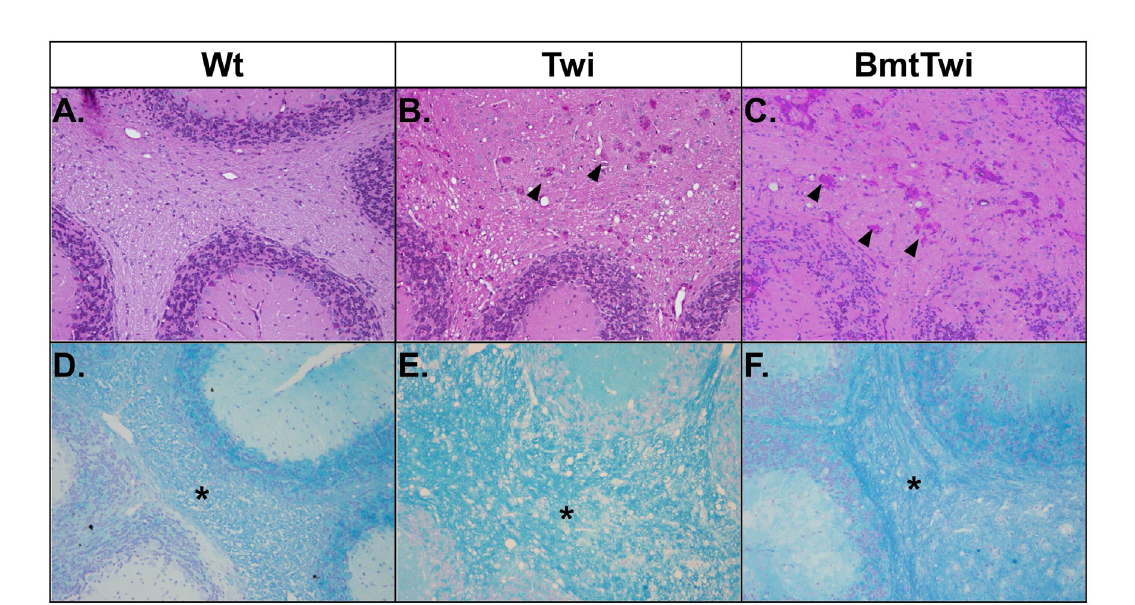
Figure 6. Histology—PAS and LFB staining. There are no identifiable PAS-positive cells in the cerebellum of the Wt animal ( A ). In the Twi ( B ), there are numerous pink multinucleated globoid cells (arrowheads). There is no obvious decrease in the number of PAS-positive cells in the BmtTwi group ( C ). Comparison of LFB staining in the cerebellar white matter (asterisk in D – F ) and cerebellar folia shows a disruption of myelin architecture (blue staining) in the Twi ( E ) mouse compared to the Wt ( D ) animal. In the BmtTwi group ( F ), the myelin architecture remains disrupted, similar to the Twi